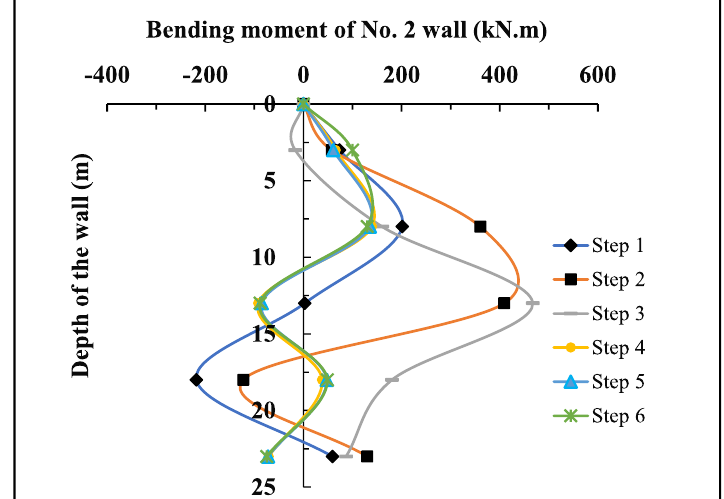
Figure 7. Bending moment of wall No. 2.